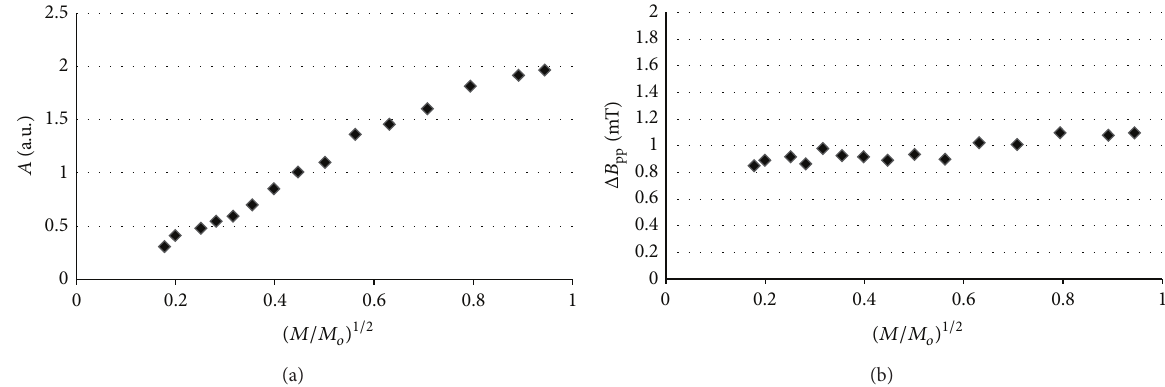
Figure 10: The effect of microwave power on (a) amplitude ( 𝐴 ) and (b) line width ( Δ𝐵 sterilized at 160 ∘ C (120 minutes). 𝑀 —microwave power used during the measurement of the EPR spectra, 𝑀 𝑜 —total microwave power produced by klystron (70